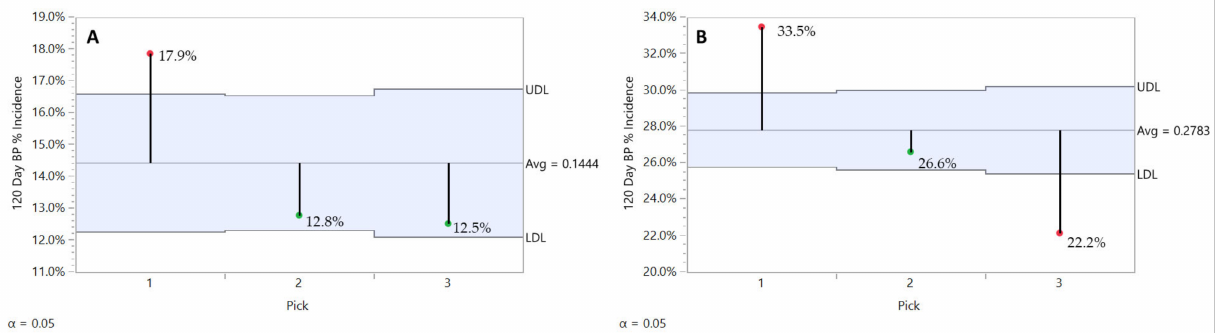
Figure 6. Pick timing effect on CV ‘Honeycrisp’ orchards ( A ) and HV ‘Honeycrisp’ orchards ( B ), bitter pit incidence after 120 days of refrigerated storage with all years combined. JMP Fit XY Platform, Analysis of Means of Proportions of the binomial dataset, alpha =